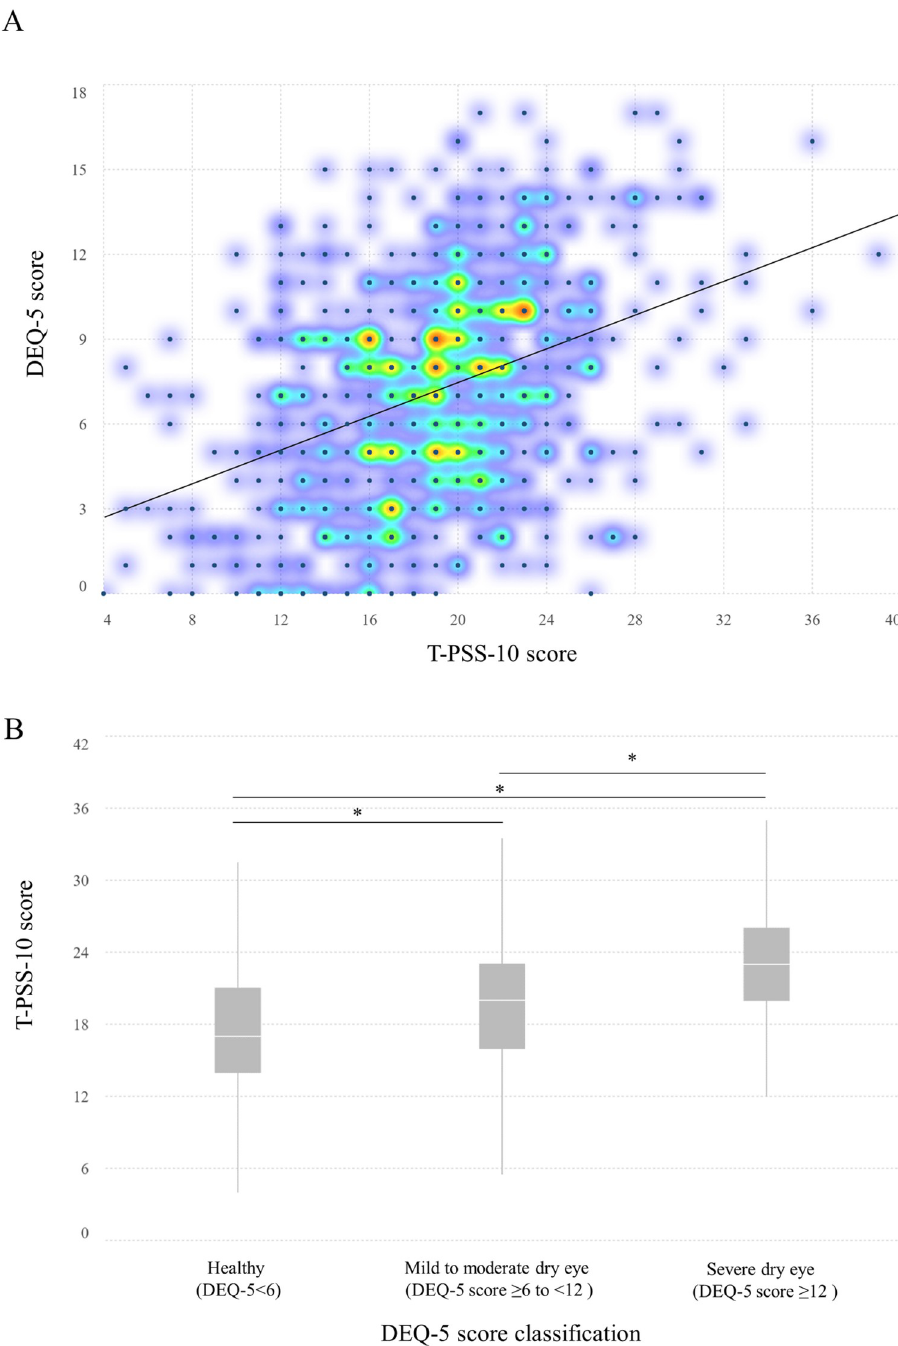
Fig 1. Distribution of T-PSS-10 and DEQ-5 scores. (A) Density scatter-plot with a correlation line between the T-PSS-10 and DEQ-5 scores of 603 respondents. Yellow indicates a higher density of points and blue indicates a lower density. (B) Box plot indicates the median T-PSS-10 among healthy, mild-to-moderate, and severe symptoms of dry eye. The asterisk shows statistically significant differences analyzed using the Mann-Whitney U test at p- value < 0.01.